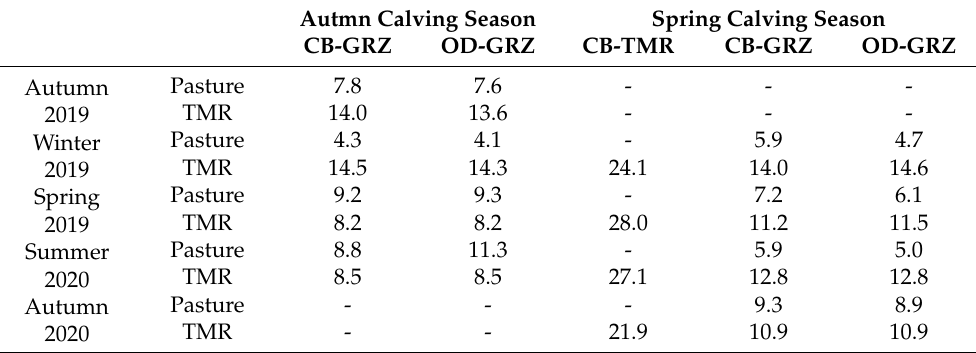
Table 3. Total mixed ration (TMR) and pasture dry matter intake (DMI) per cow (kg DM/day) in the autumn and spring calving seasons in confined (CB-TMR) and mixed systems with low (CB-GRZ) or high (OD-GRZ) environmental exposure during complete lactation.